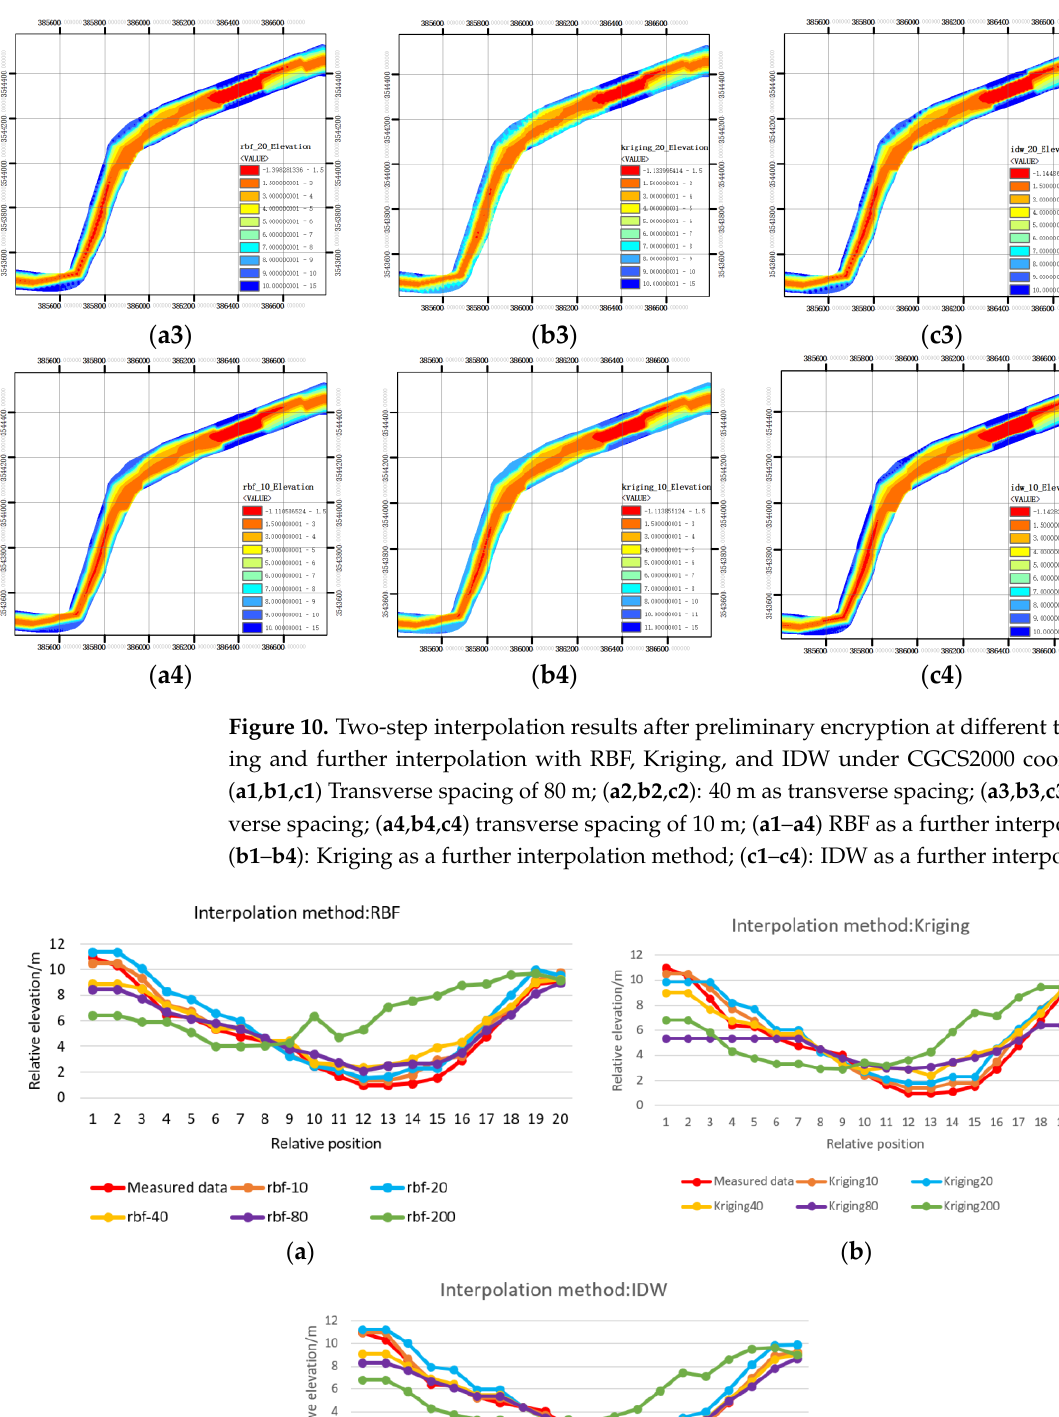
( d ) Figure 12. Comparison of interpolation results of different sections with the same interval spacing (10 m): ( a ) Section 1; ( b ) Section 2; ( c ) Section 3; ( d ) Section 4. In order to more objectively analyze the simulation effects of the different interpola- tion methods and different intervals, RMSE and MAE were taken as the evaluation indices of the final terrain simulation, and the results are shown in Table 1. When the original sampling points were directly calculated by the interpolation algorithm, the MAE and RMSE values of the elevations simulated by the three interpolation methods reached